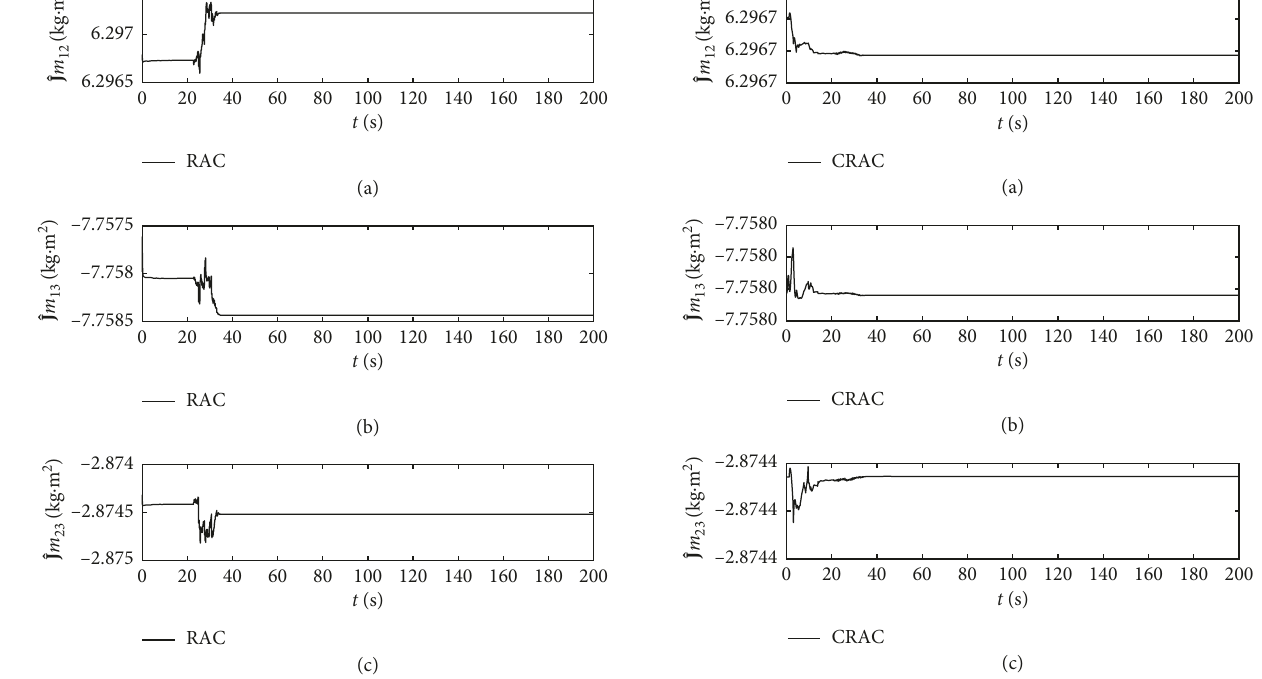
Figure 12: Time response of estimated parameters of the product of inertia in Case 2.